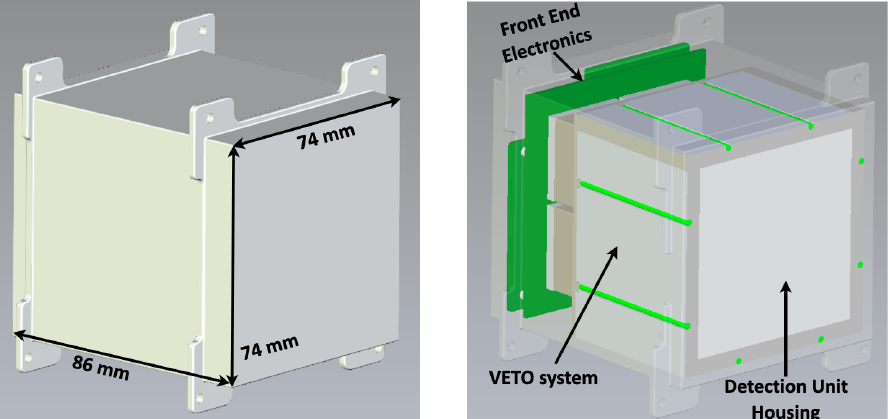
Figure 3. ( Left ) The outer box containing the reference detector studied in this paper. The enclosure might be either machined form solid aluminum or developed by additive manufacturing process (3D printing) and shaped to mechanically fit in the CubeSat mechanical structure. ( Right ) The schematic layout of the reference detector. Visible in the picture are the electronics, the rejection layer (VETO) for charged particle induced events, and the inner housing for the detection unit are also labeled. For a payload fitting in 1U volume, the overall mass unit should not exceed 1.3 kg, however small deviations are possible, depending on the launch vehicle. The overall weight is in general constrained by the characteristics of the deployment